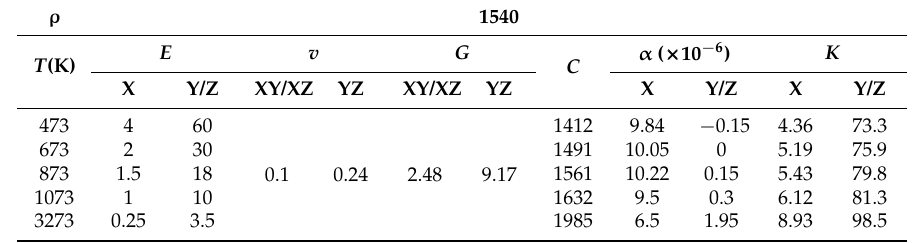
Table 2. Material properties of C/C composite [34].